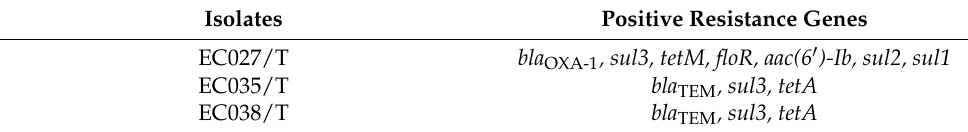
Table 7. Gene detection of conjugation resistance.